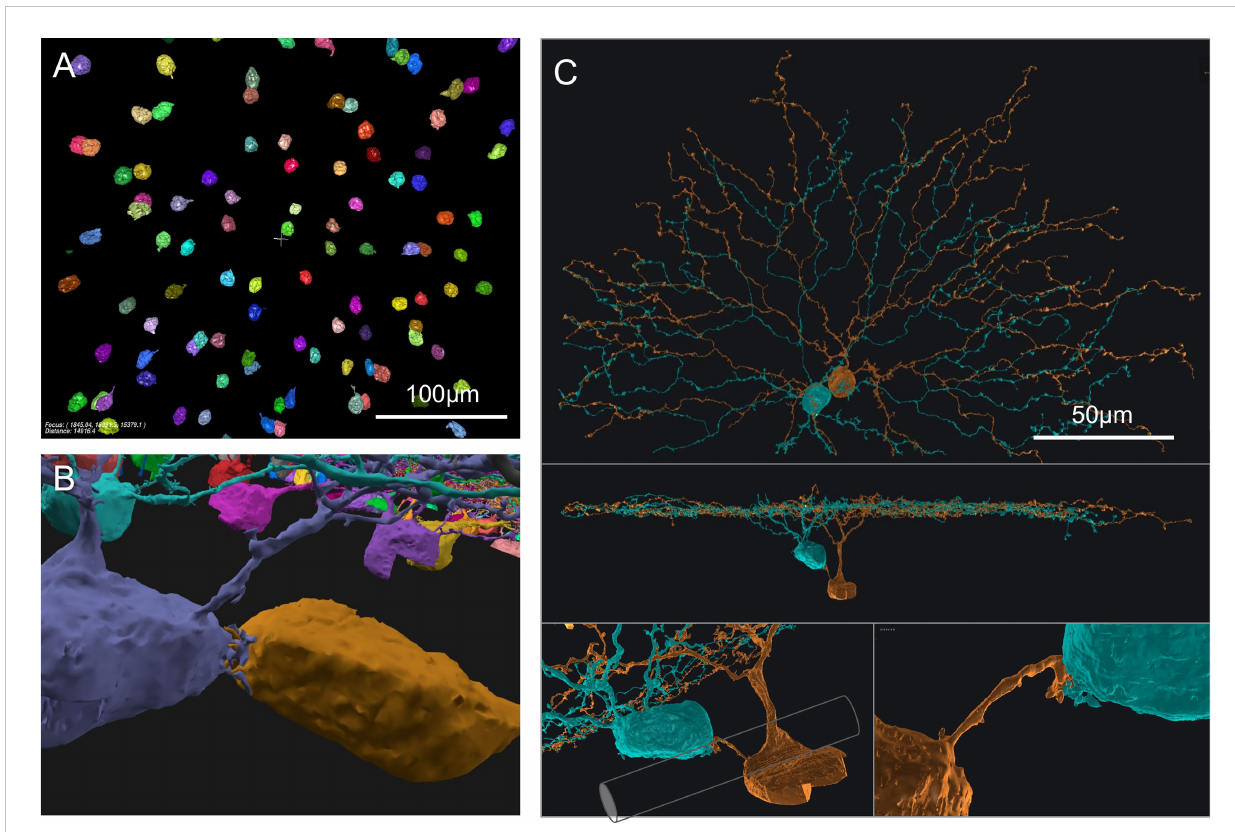
FIGURE 2 On SAC distribution and contacts. (A) Distribution of On SAC somas (colored objects are the 3D-reconstructed full or partial somas) in a fl at-mount view of the retinal patch. (B) A pair of contacting On SACs form twigs at their soma contact (also in the background are somas of other On SACs, often incompletely reconstructed due to dataset boundaries). (C) A pair of On SACs that were next to each other in fl at-mount view (top) did not have direct soma contact but were instead bridged by a short process between the somas (additional views in the middle and bottom panels). The two somas were separated by an axon bundle (illustrated by a cylindrical shape overlay within the bottom left panel) of retinal ganglion cells. Scale bars: 100 m m (A) ; 50 m m (C)